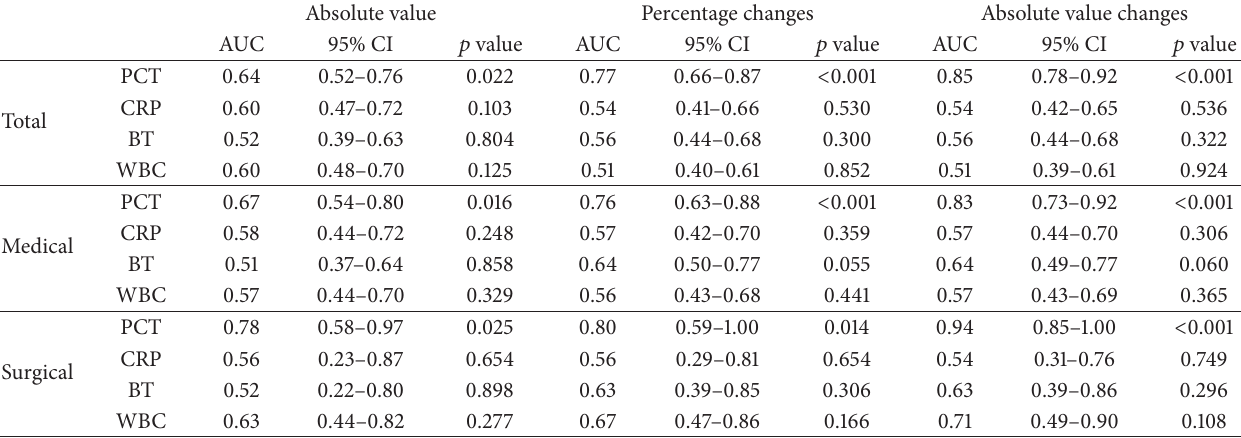
Figure 2: PCT, CRP, body temperature, and WBC count absolute values in the total cohort. Boxplots present median (interquartile range) 10th and 90th percentile. ∗ indicates 𝑝 < 0.05 . Table 4: The predictive value of the absolute values, percentage, and delta changes of PCT, CRP, temperature, and WBC count for infection in the total